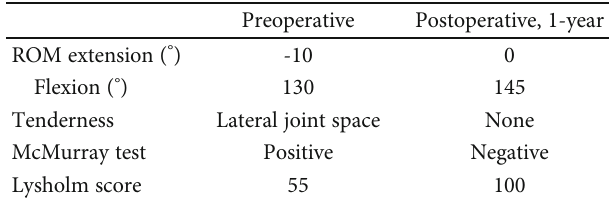
Table 1: Pre- and postoperative physical examination in hypermobile anterior horn of the lateral